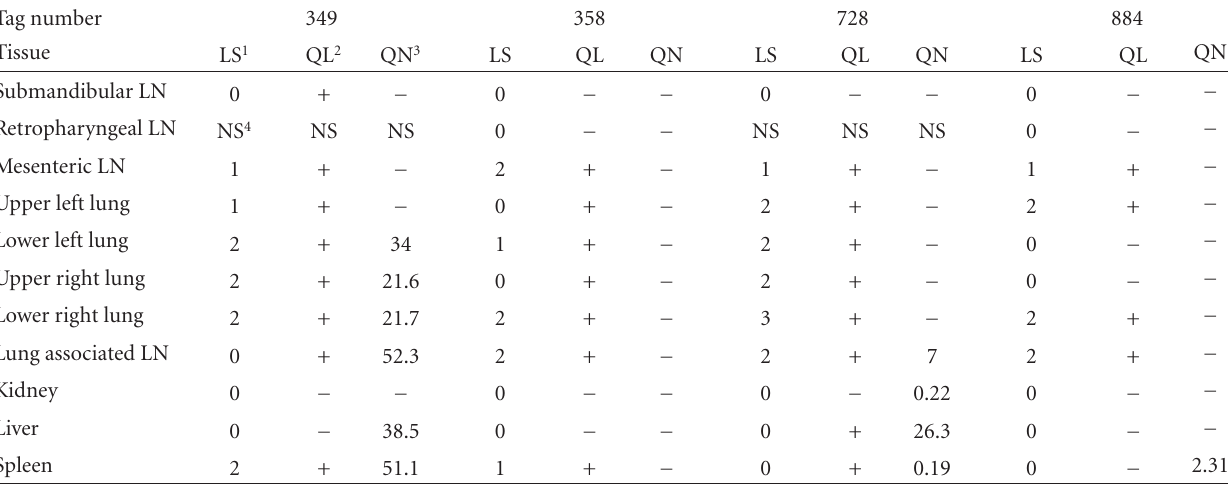
Table 2: Isolation of M. bovis from a range of tissues taken from 4 ferrets infected with 1 . 1 × 10 3 CFU and examined postmortem at 8 weeks post infection.